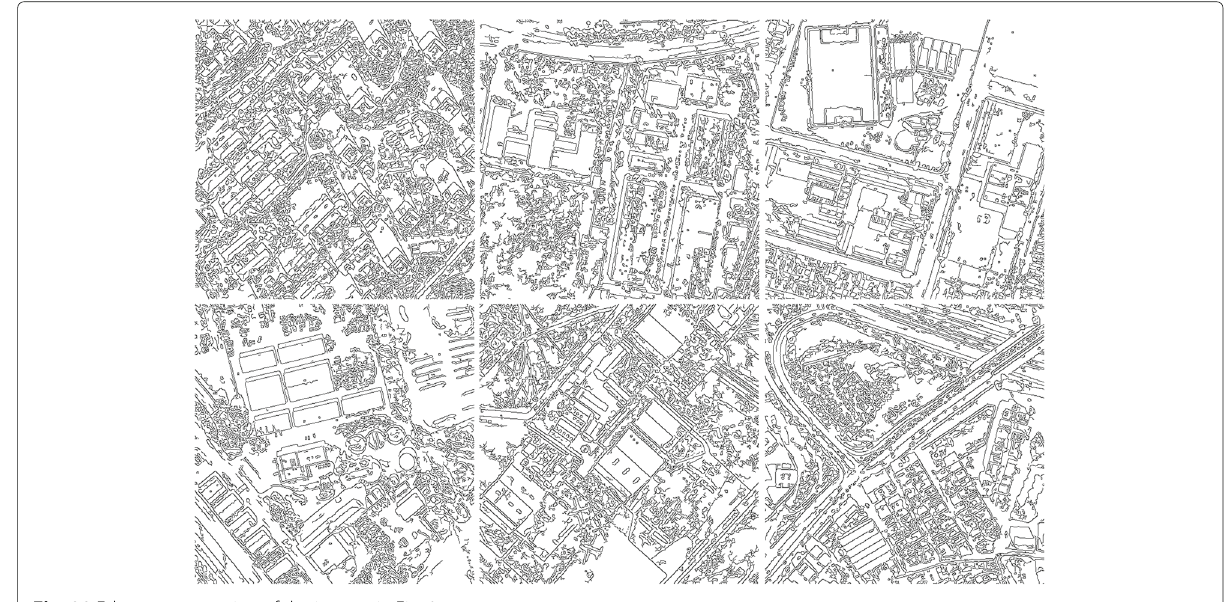
Regarding corner detection, our proposal provides an alternative to intensity-based detectors. These methods present some limitations in the detection of corners of obtuse angles, since in the local environment of those points significant intensity changes are only perceived in one direction [42]. In our approach, corners are con- sidered as image points intersecting two line segments at a given angle range. This corner definition is con- sistent with certain cell patterns in the Hough